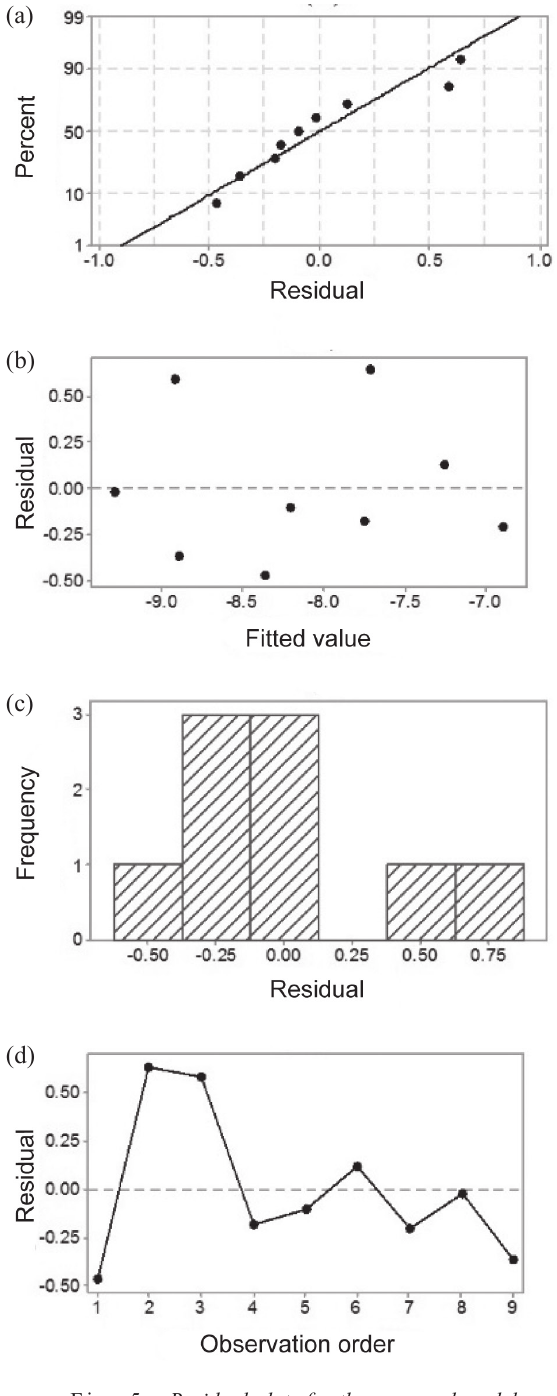
Fig. 5 – Residual plots for the proposed